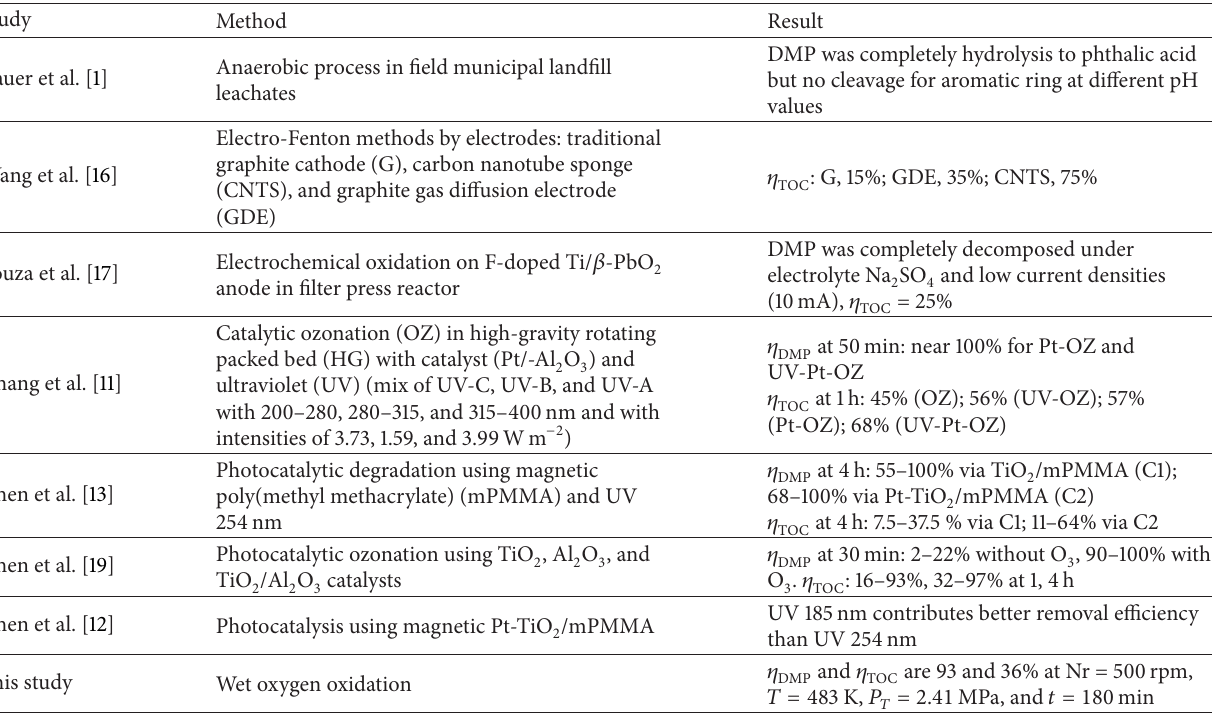
Table 2: Comparison with some results of others for the decomposition of DMP via various methods.